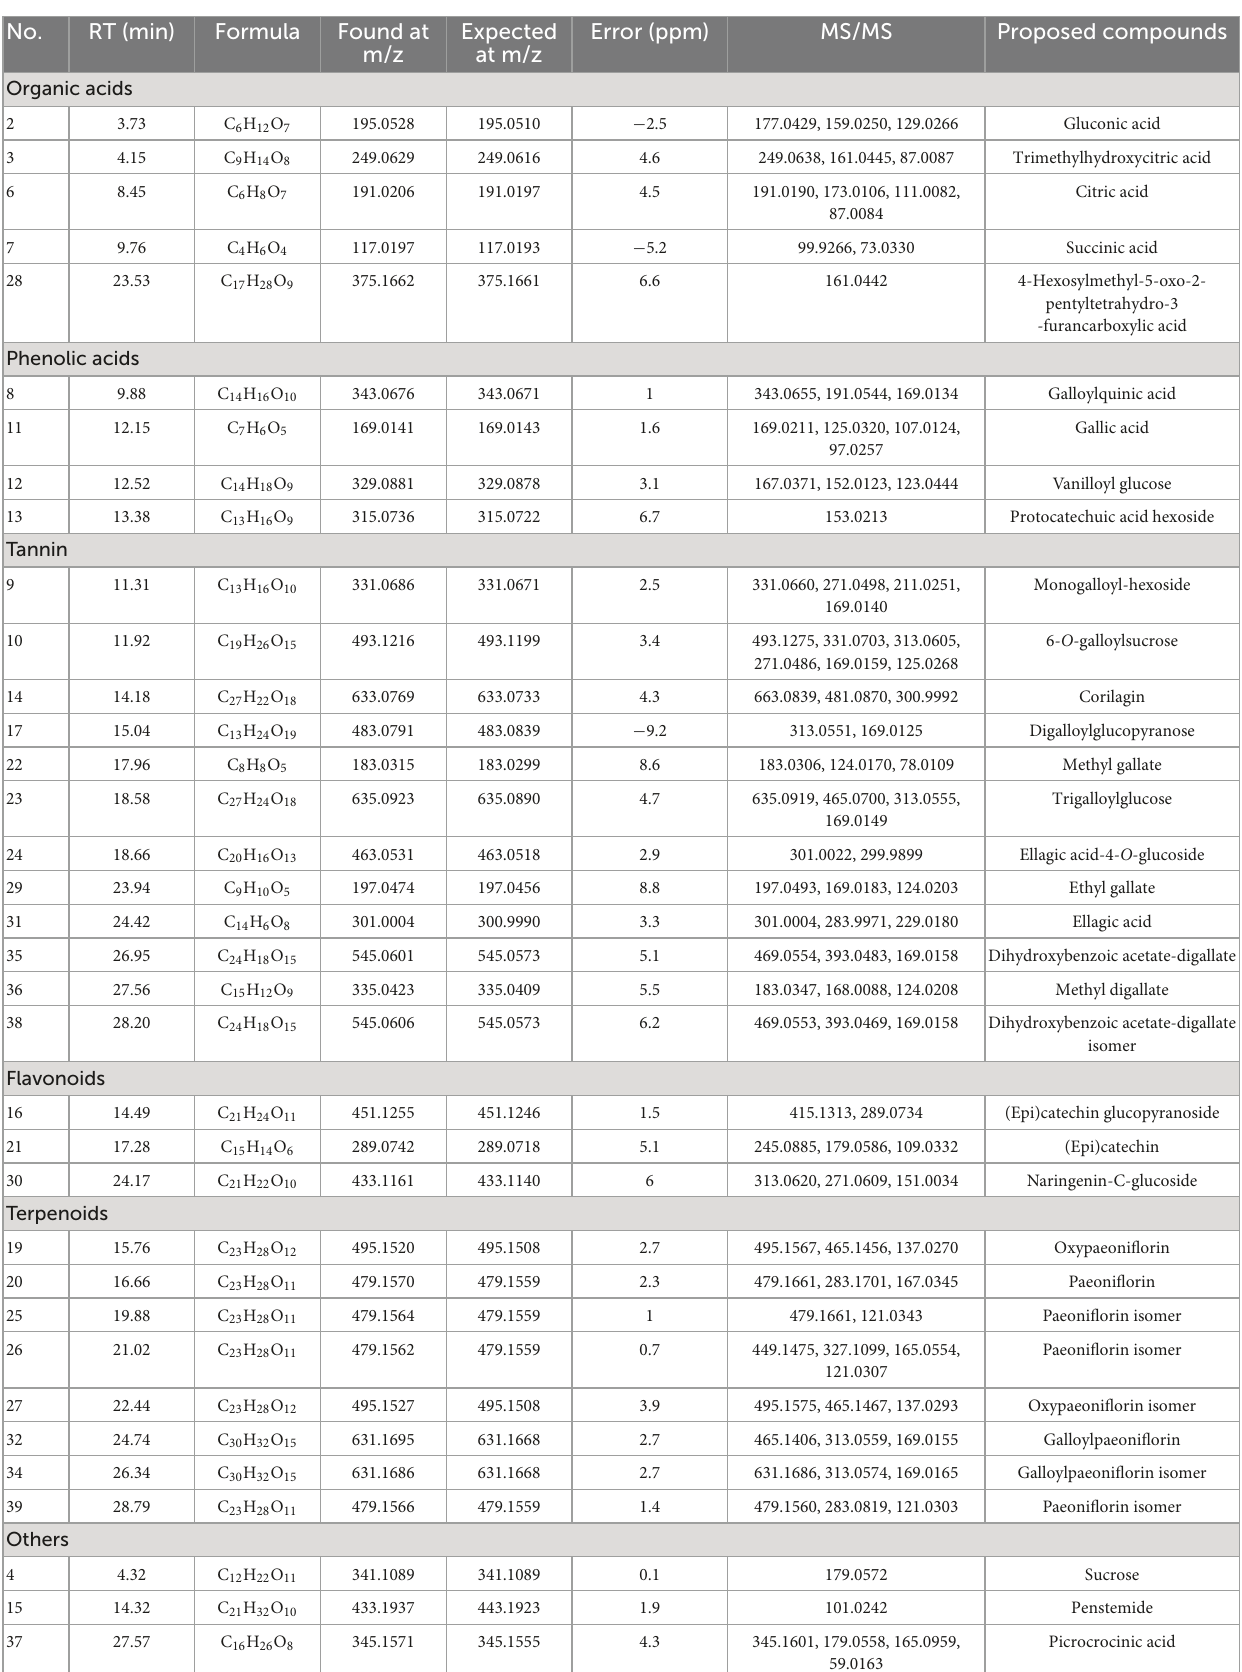
TABLE 2 Identified and tentatively identified compounds in the 70% ethanol extract of PRA by HPLC-QTOF-MS/MS under negative ion mode.